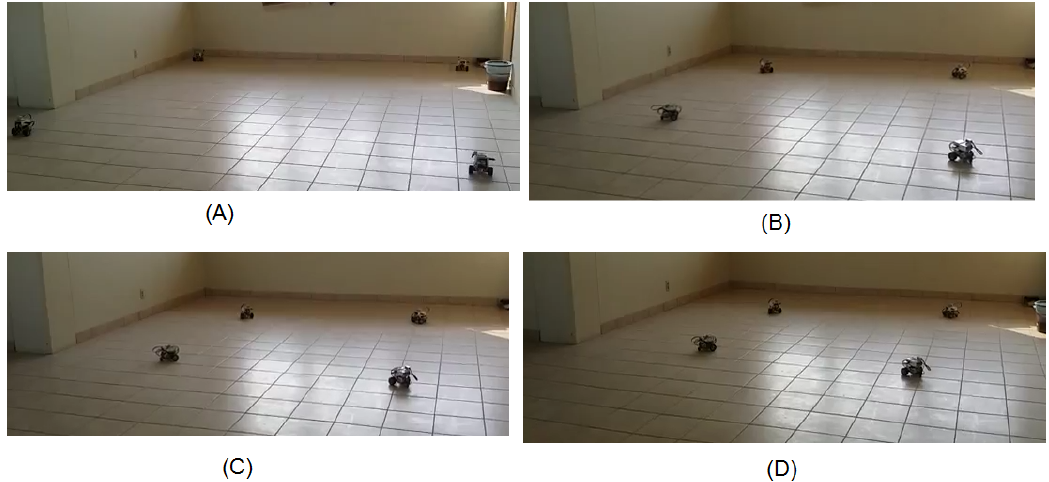
Figure 14. Attractive force test using four EV3 robots. ( A ) The initial position of the robots. ( B ) Robots after moving one step. ( C ) Robots after moving another step. ( D ) Final deployment.